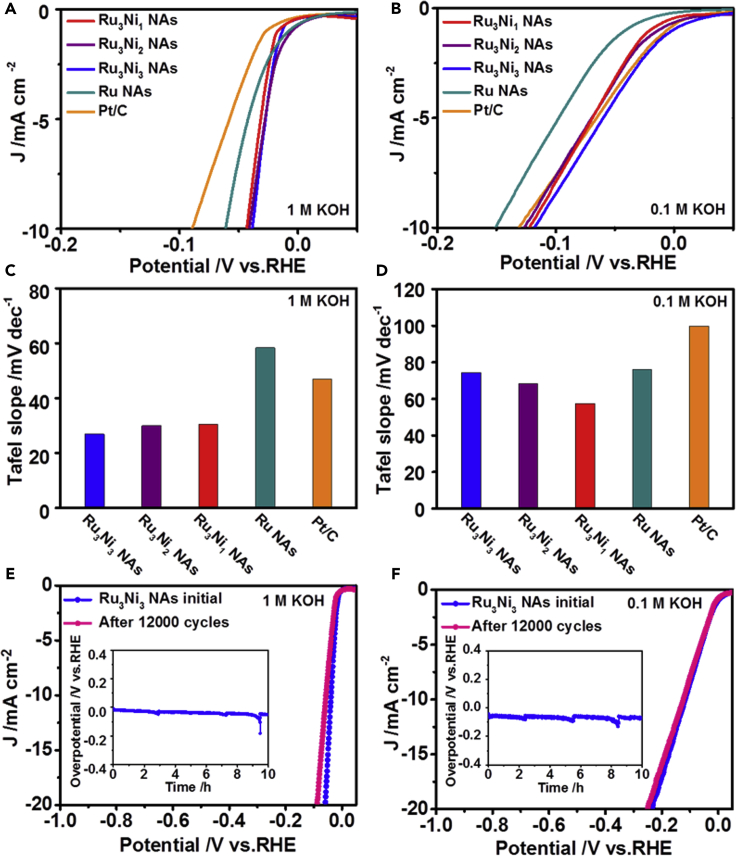
HER Performances of the Ru3Ni3 NAs, Ru3Ni2 NAs, Ru3Ni1 NAs, Ru NAs, and Pt/C under Different Alkaline Conditions(A and C) (A) The polarization curves and (C) corresponding Tafel plots in 1 M KOH.(B and D–F) (B) The polarization curves and (D) corresponding Tafel plots in 0.1 M KOH. Scan rate is 5 mV s−1. Polarization curves of the Ru3Ni3 NAs before and after 12,000 cycles in (E) 1 M KOH and (F) 0.1 M KOH solutions at a scan rate of 5 mV s−1. Insets: chronopotentiometry curves of the Ru3Ni3 NAs in 1 M KOH and 0.1 M KOH solutions at a constant current density of 5 mA cm−2.